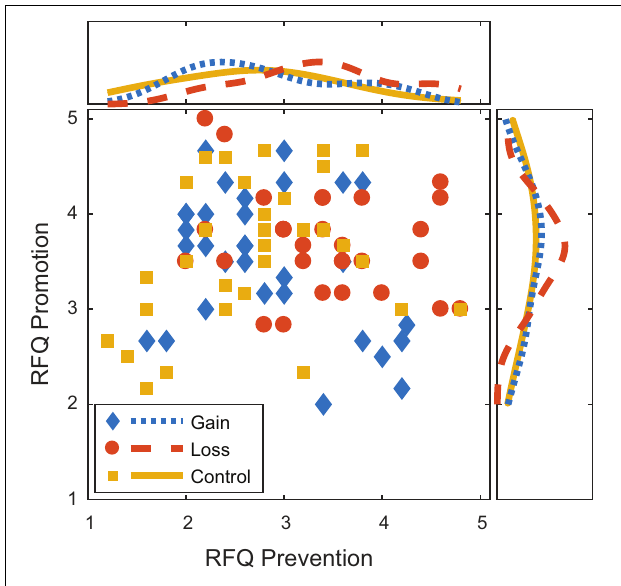
FIGURE 2 | Prevention and promotion subscales for the regulatory focus questionnaire by experimental condition. Marginal plots show Gaussian smoothed histograms for prevention (top) and promotion (right) strengths to illustrate the relative frequencies of those